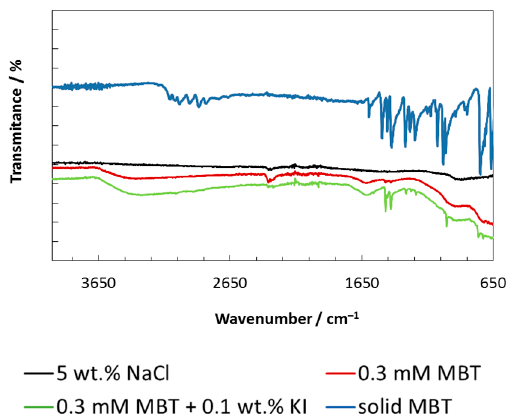
Figure 8. ATR-FTIR spectra of the AA6082 aluminium alloy samples immersed for 31 days in 5 wt.% NaCl solution with the addition of 0.3 mM MBT or a combination of 0.3 mM MBT and 0.1 wt.% KI. The ATR-FTIR spectra of the pure solid MBT is given also for comparison.